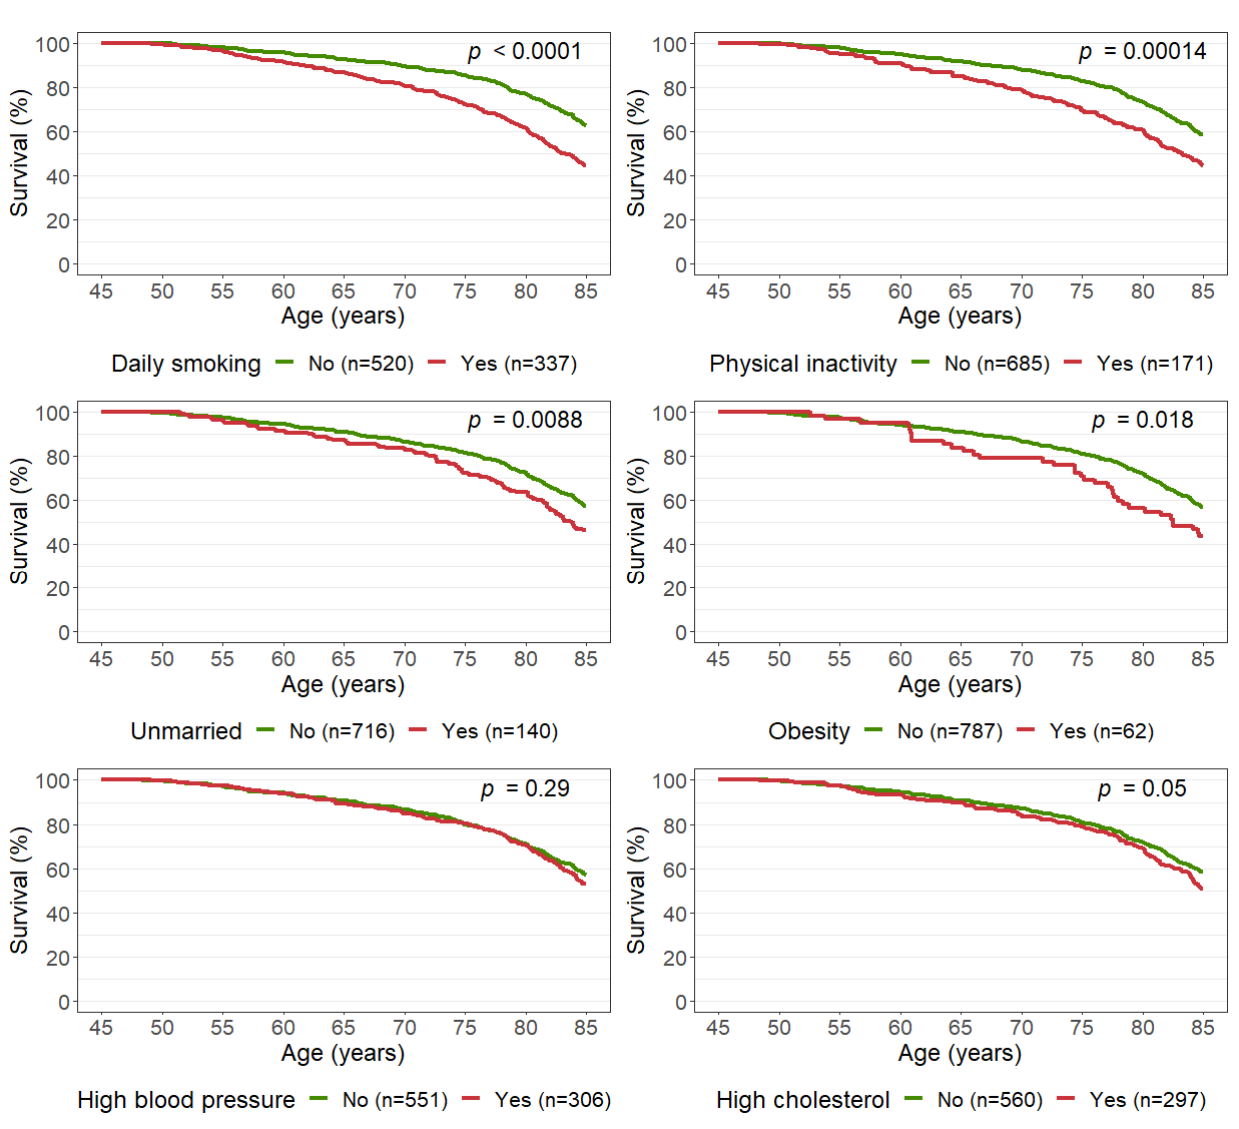
Figure 1. Survival curves for all ‐ cause mortality according to risk factors observed at age 45–49 years (Tromsø2). The Tromsø Study 1979–2019. Obesity: body mass index ≥ 30 kg/m 2 ; high blood pressure: blood pressure medication, systolic blood pressure ≥ 140 mmHg, or diastolic pressure ≥ 90 mmHg; high cholesterol: total cholesterol > 7 mmol/L. Table 2. Hazard ratios for all ‐ cause mortality from a multiple Cox model with risk factors observed at ages 45–49 years (Tromsø2). The Tromsø Study 1979–2019.